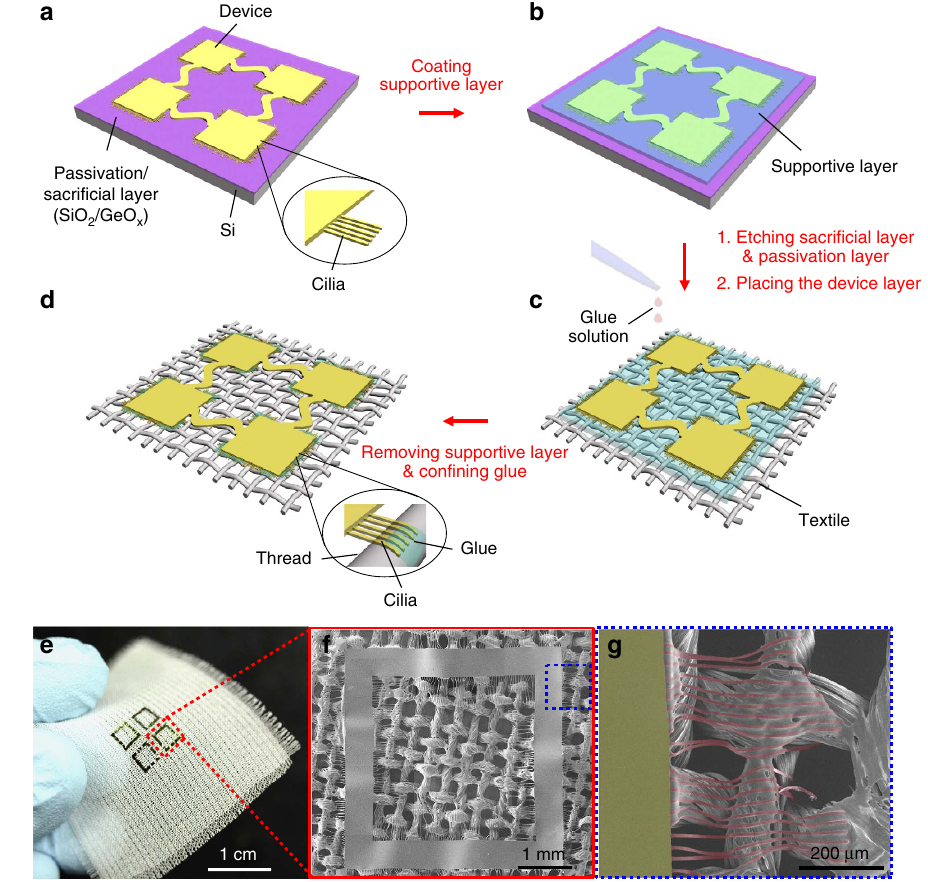
Figure 1 | Schematic procedure for cilia-assisted transfer printing. ( a – d ) Illustration of steps for transfer printing of ultrathin devices with peripheral cilia onto a textile. ( e – g ) Photograph ( e ) and selected SEM ( f,g ) images of 2 (cid:2) 2 open square pattern arrays of PI (thickness ¼ 2 m m)/Cr (70nm)/PI (2 m m) layered structure with PI (thickness ¼ 1.8 m m) peripheral cilia transferred onto a textile. The image ( g ) was colorized with olive (corresponding to main substrate) and red (corresponding to peripheral cilia) to enhance the contrast between variable